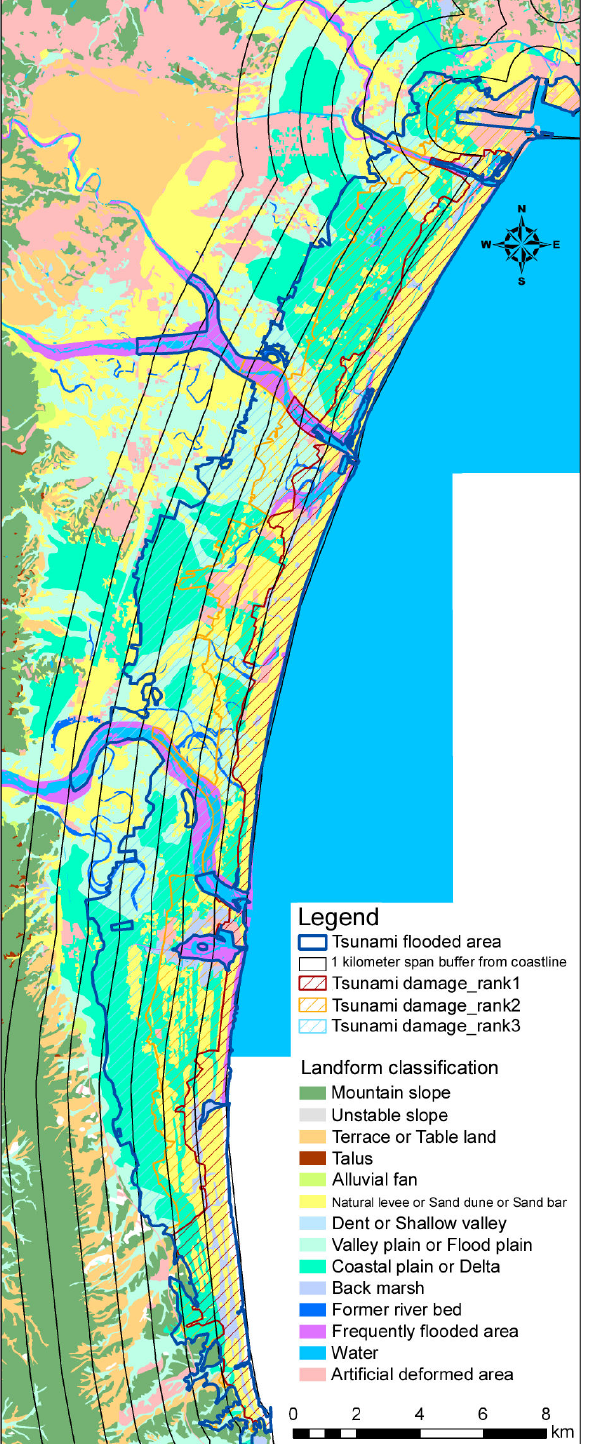
Figure 7. Overlay of tsunami damage and landform classification